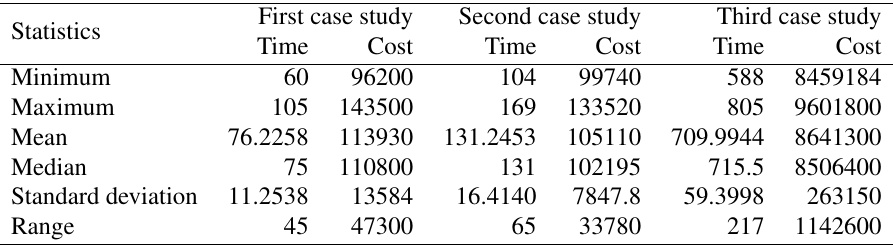
Table 4. Statistical analysis for tradeoff points